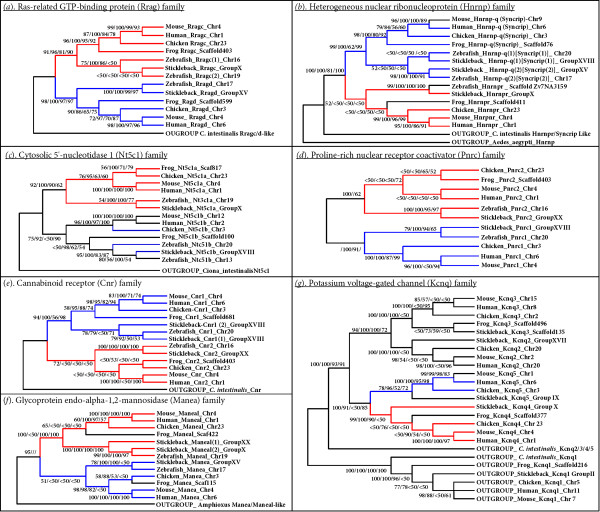
Phylogenetic reconstruction of vertebrate gene families with members in chromosomal proximity to both akirin1 and akirin2. The corresponding amino acid alignments employed are provided in additional file 3. The shown topologies (a-g) were obtained by NJ and unless mentioned otherwise in the main text, were comparable to those produced by Bayesian, ML and MP analyses. Branch confidence values greater than 50% from each approach are shown in the order NJ/Bayesian/ML/MP. The ras-related GTP-binding family (rragc and rragd) (a), heterogeneous nuclear ribonucleoprotein family (hnrnp-r and hnrnp-q [HGNC name-Syncrip]) (b), cytosolic 5'-nucleotidase 1 family (nt5c1a and nt5c1b) (c), proline-rich nuclear receptor coactivator family (pnrc1 and pnrc2) (d), cannabinoid receptor family (cnr1 and cnr2) (e) and glycoprotein endo-alpha-1,2-mannosidase family (manea and maneal) (f) each contained two members in all non-teleost vertebrate genomes examined and were, with limited exceptions, present in syntenic chromosomal regions (or double conserved syntenic regions in some teleosts- see fig. 5 and fig. 6) where one family member was located near akirin1 and the other near akirin2. The potassium voltage-gated channel (kcnq) family (Kcnq1/2/3/4/5) (g) contains two family members (kcnq4 and kcnq5) that are, in most vertebrates, in genomic proximity to akirin1 and akirin2 respectively. Further details about each phylogenetic analysis are provided in the text. To summarise, the branching patterns for each of these families was compatible with a duplication event in the vertebrate lineage of chordates and was also concomitant to their genomic location in relation to akirin1 (indicated by red branches) and akirin2 (indicated by blue branches).